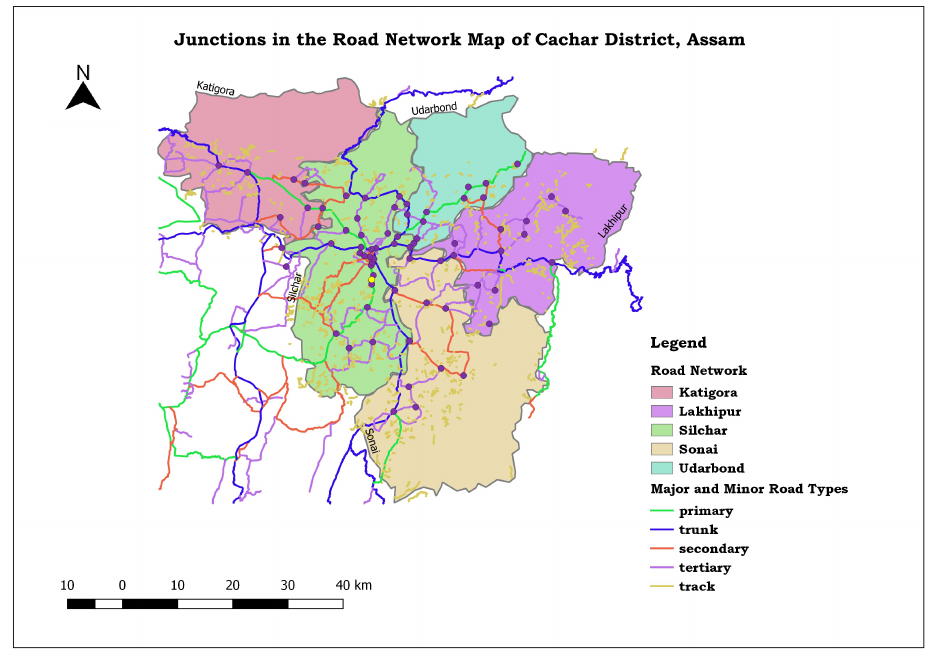
Figure 3. Junctions in the road network.